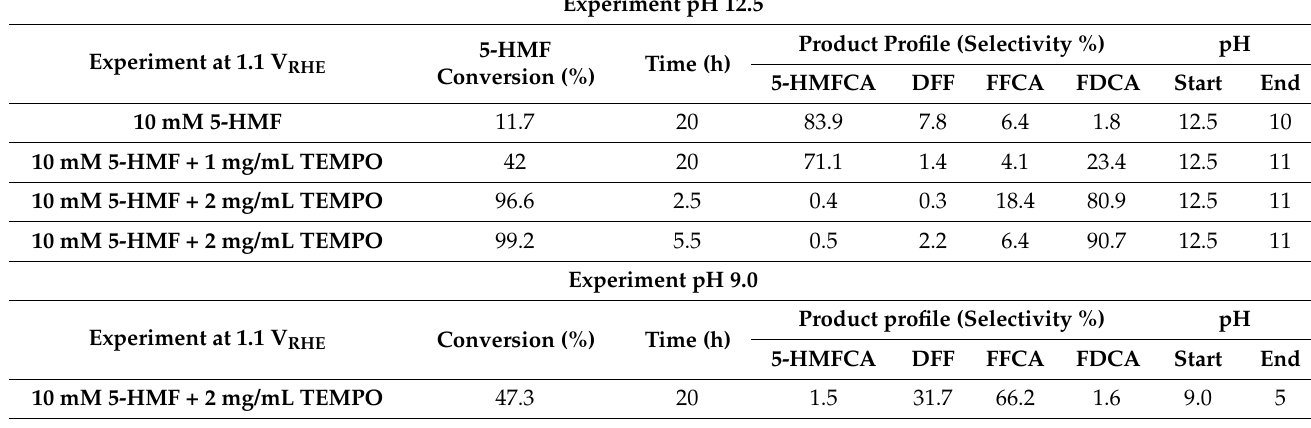
Table 1. Photoelectrochemical oxidation of 5-HMF and derivatives using hematite photoanode at 20 ◦ C and different pH values. Experiment pH 12.5 Experiment at 1.1 V